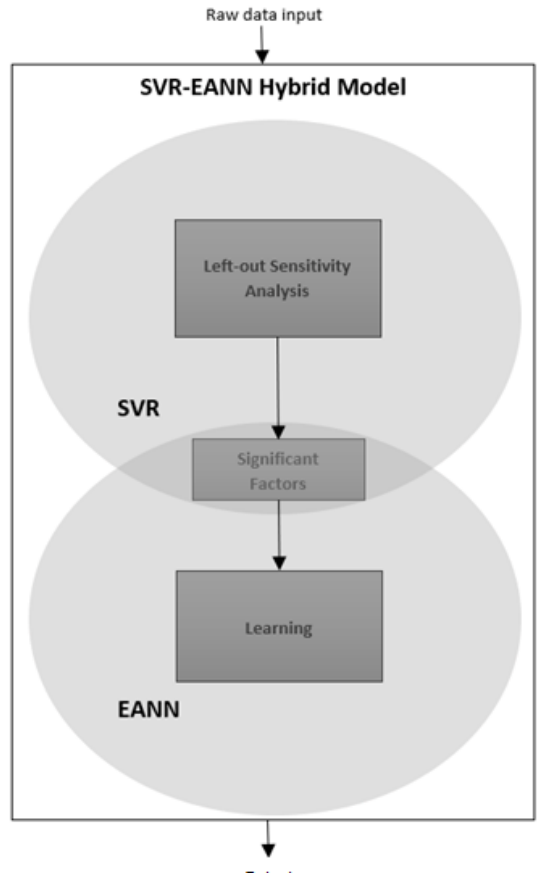
Figure 5. Block diagram of the proposed SVR ‐ EANN hybrid model.